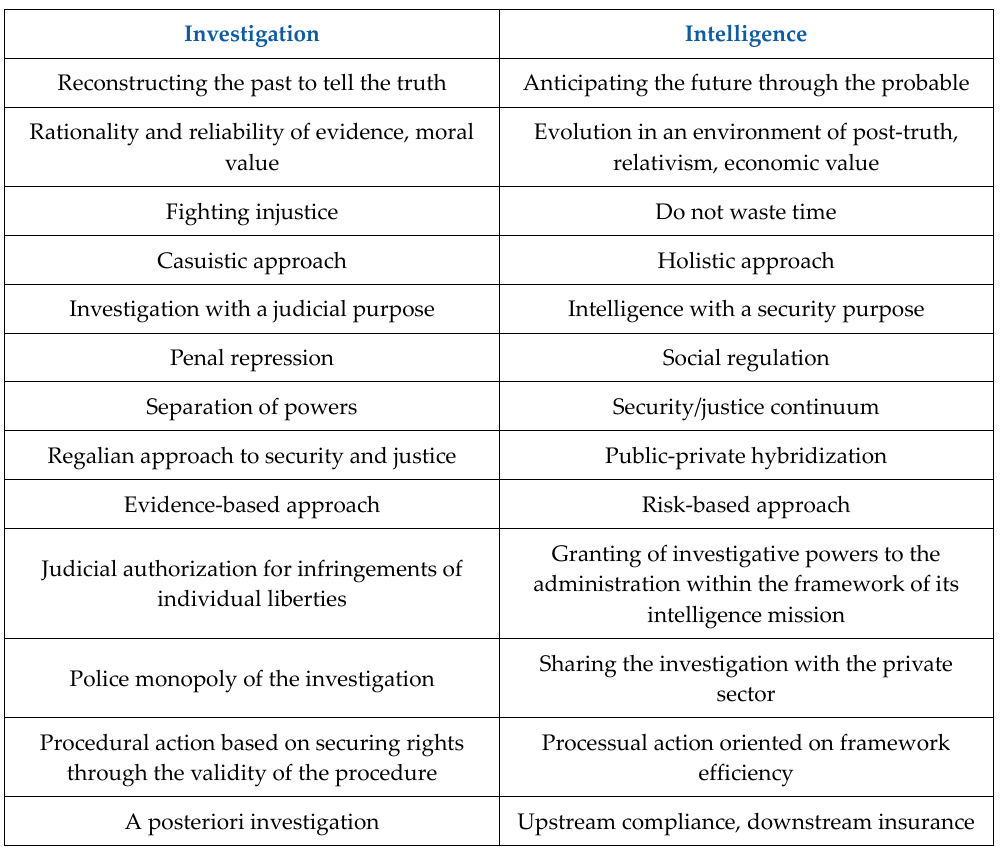
Figure 3. Paradigm shift between investigation and intelligence.